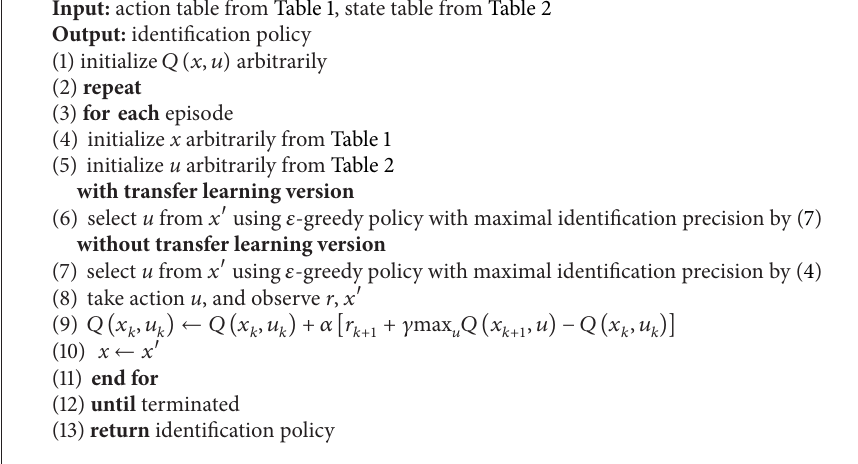
Input: action table from Table 1, state table from Table 2